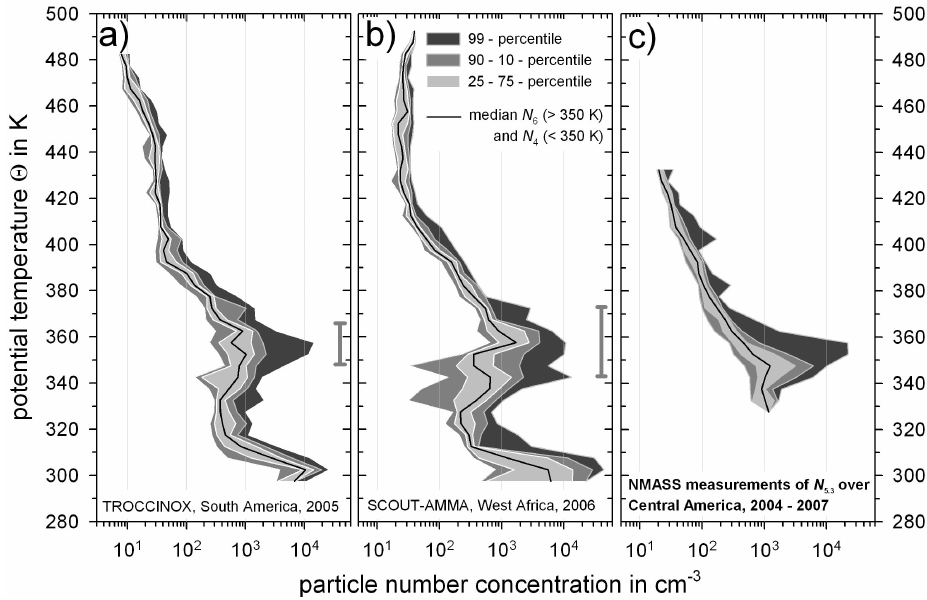
Fig. 1. Vertical profiles of total particle number densities (for particle diameters larger than 6nm for 2> 350K and 4nm for 2< 350K, and up to ≈ 1µm) for all tropical flights of the M-55 Geophysica and the DLR Falcon -20 during (a) TROCCINOX and (b) SCOUT-AMMA. Median values are shown (black line), as well as 10th, 25th, 75th, 90th, and 99th percentiles (grey-scale contours). Frequent occurrence of New Particle Formation events (99th percentiles) influences the median over South America in the 11–13.5km altitude range and over West Africa in the 9–14km altitude range. (c) Measurement results from the NMASS (on the NASA WB-57F) over Central America between 2004 and 2007 indicating frequent occurrence of high particle number densities (for particle diameters > 5.3nm) in the same altitude